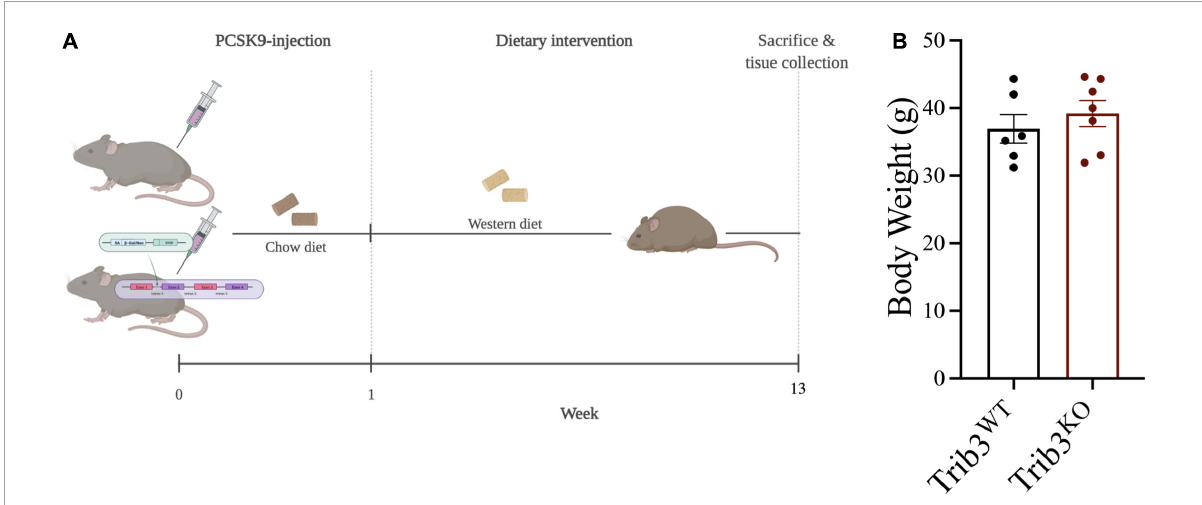
FIGURE2 Atherosclerosis model and weight gain in Trib3 KO mice. (A) Schematic representation of atherosclerosis development model used in Trib3 WT and Trib3 KO mice. (B) Body weight measurements in Trib3 WT and Trib3 KO mice at 13